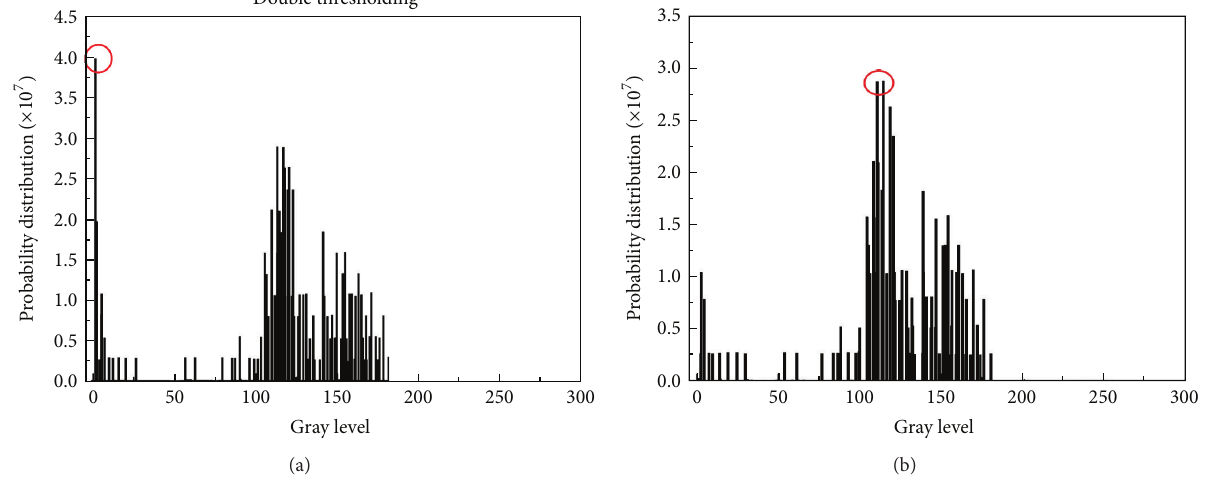
Figure 5: Dual thresholding.